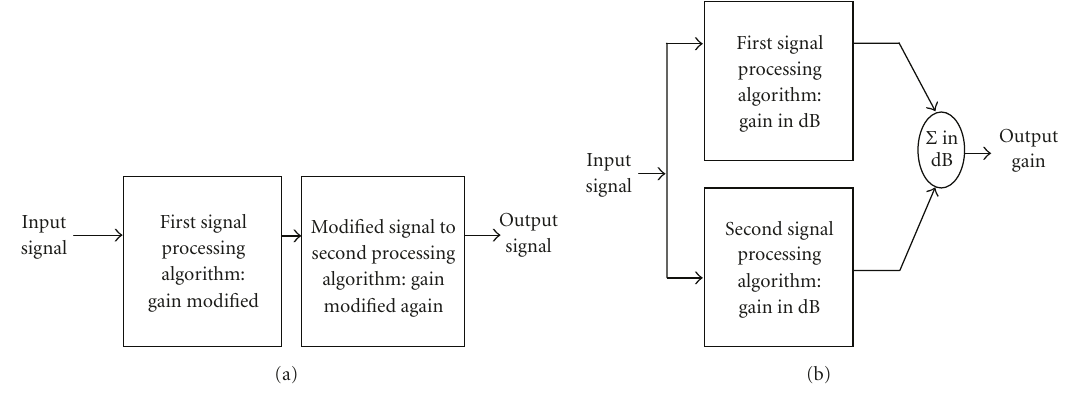
Figure 1: Block diagrams depicting (a) series and (b) parallel